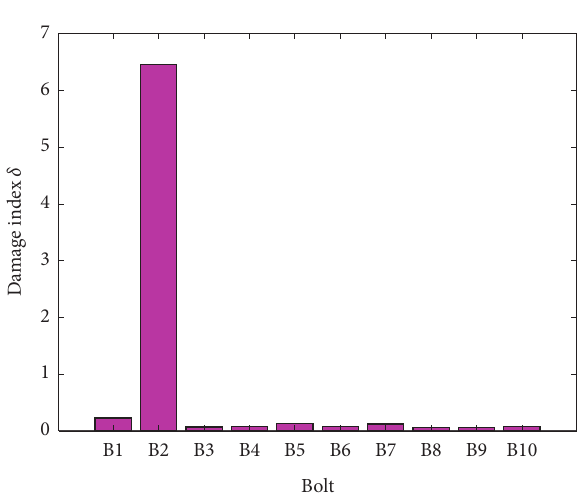
Figure 9: Histogram of bolt looseness damage index